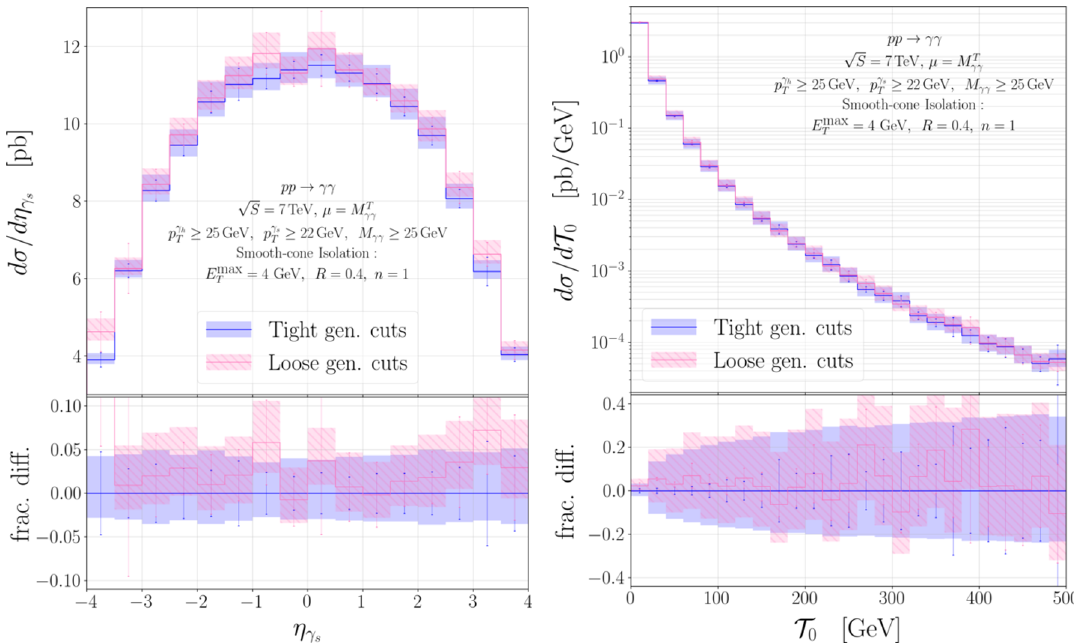
Figure 12 . Comparison between two different sets of generation cuts (see text for additional details) for the pseudorapidity of the softer photon (left) and the T 0 distribution (right). Figure 13 . Comparison between Geneva + Pythia8 results after applying two different gen- eration cuts and the same analysis cuts. The theoretical predictions have been produced by ap- plying the Rivet analysis ATLAS_2012_I1199269 to the hadronised events. We show the trans- verse momentum of the photon pair (left) and the cosine of the photon angle in the Collins-Soper frame